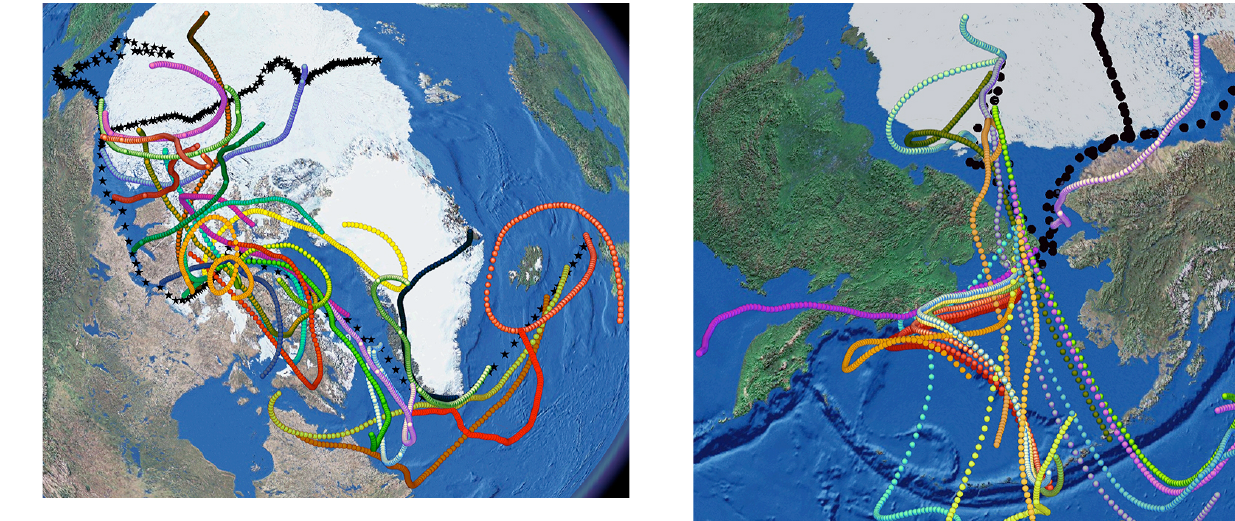
Figure 2 . Cruise track illustrated by ship’s position every 6 h (black stars) and for July plots of selected daily five-day back-trajectories starting (usually at 12 h UTC) at 100-1,500 m above sea level. The offset in starting elevation was chosen individually to produce a purposeful stable trajectory lacking of significant ground contact. The snow/ice coverage shown in the image does not represent the actual distribution during the cruise.